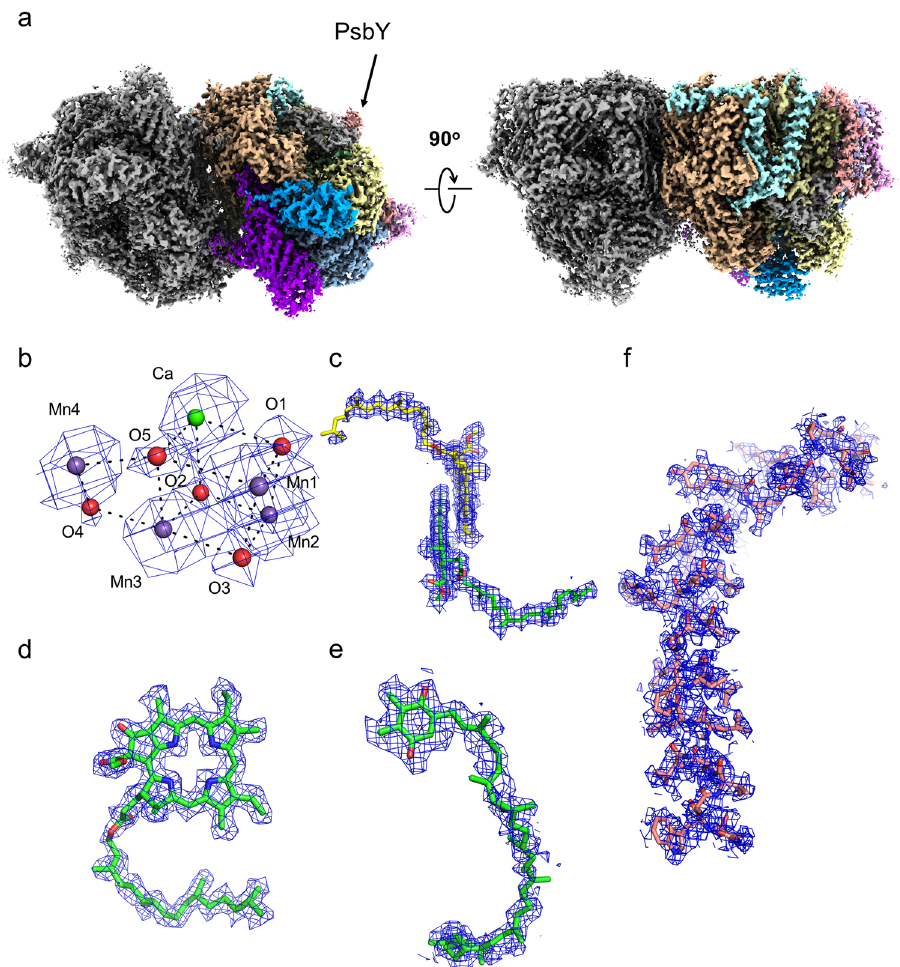
Fig. 2 Overall structure of PSII at a high-dose. a The cryo-EM density of PSII at 1.95 Å resolution from the ARM-60k dataset. The cryo-EM density of cofactors, OEC ( b ), P680 ( c ), pheophytin ( d ) and plastoquinone (Q B ) ( e ), superimposed with the re fi ned model. f The density of PsbY superimposed with the re fi ned model. The densities were depicted at 5 σ